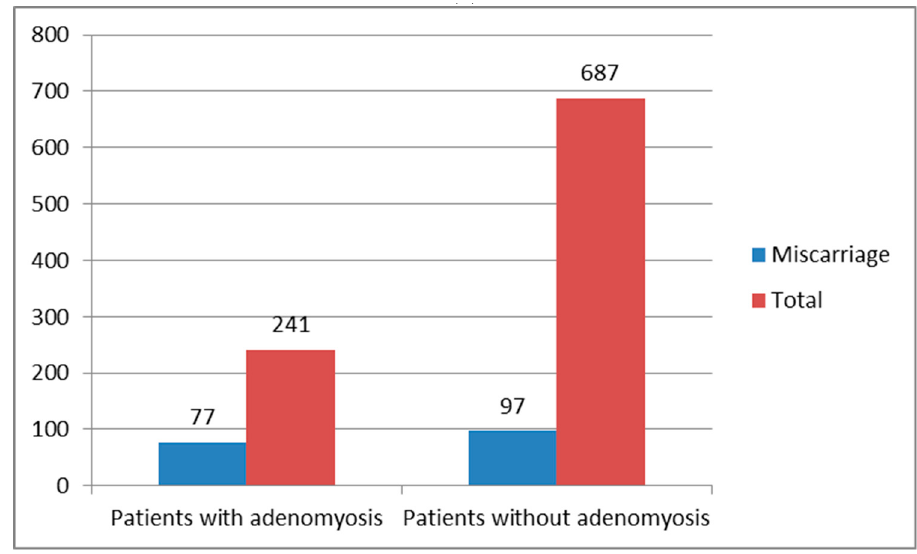
Figure 4. ( a ): Clinical pregnancy rates after ART in patients with and without adenomyosis [43]. The clinical pregnancy rate achieved after ART was 123/304 (40.5%) in women with adenomyosis versus 628/1262 (49.8%) in those without adenomyosis. ( b ): Miscarriage rates after ART in patients with and without adenomyosis [43]. A miscarriage was observed in 77/241 women with adenomyosis (31.9%) and in 97/687 in those without adenomyosis (14.1%).